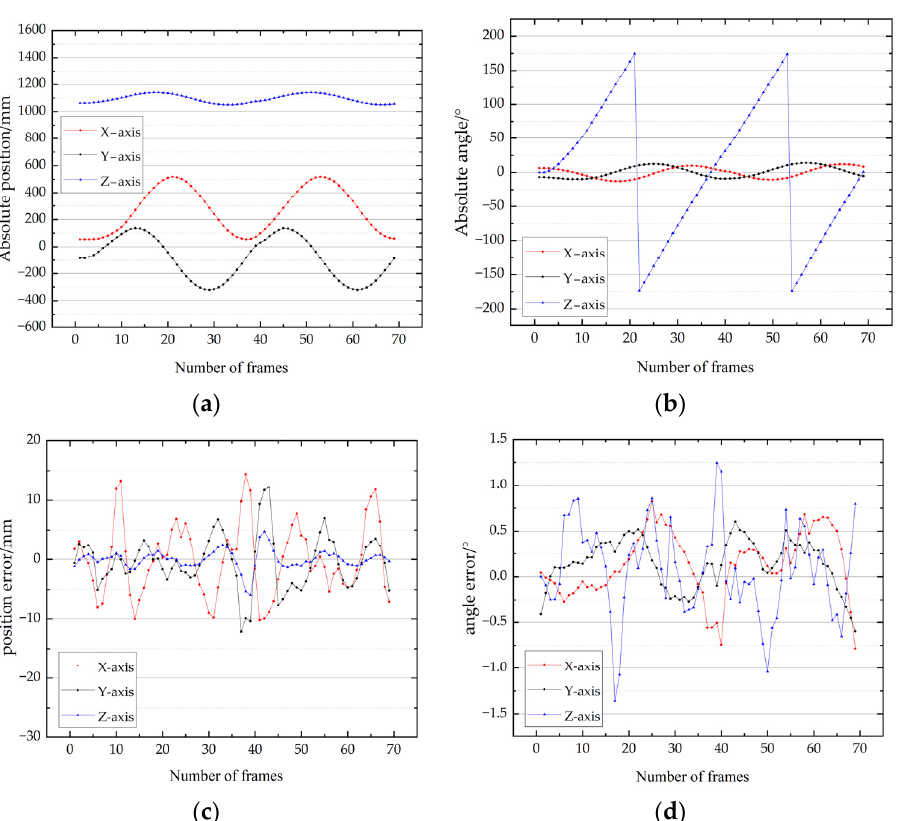
Figure 17. Pose estimation experimental results at high speed: ( a ) absolute position; ( b ) absolute angle; ( c ) error of position; ( d ) error of angle.